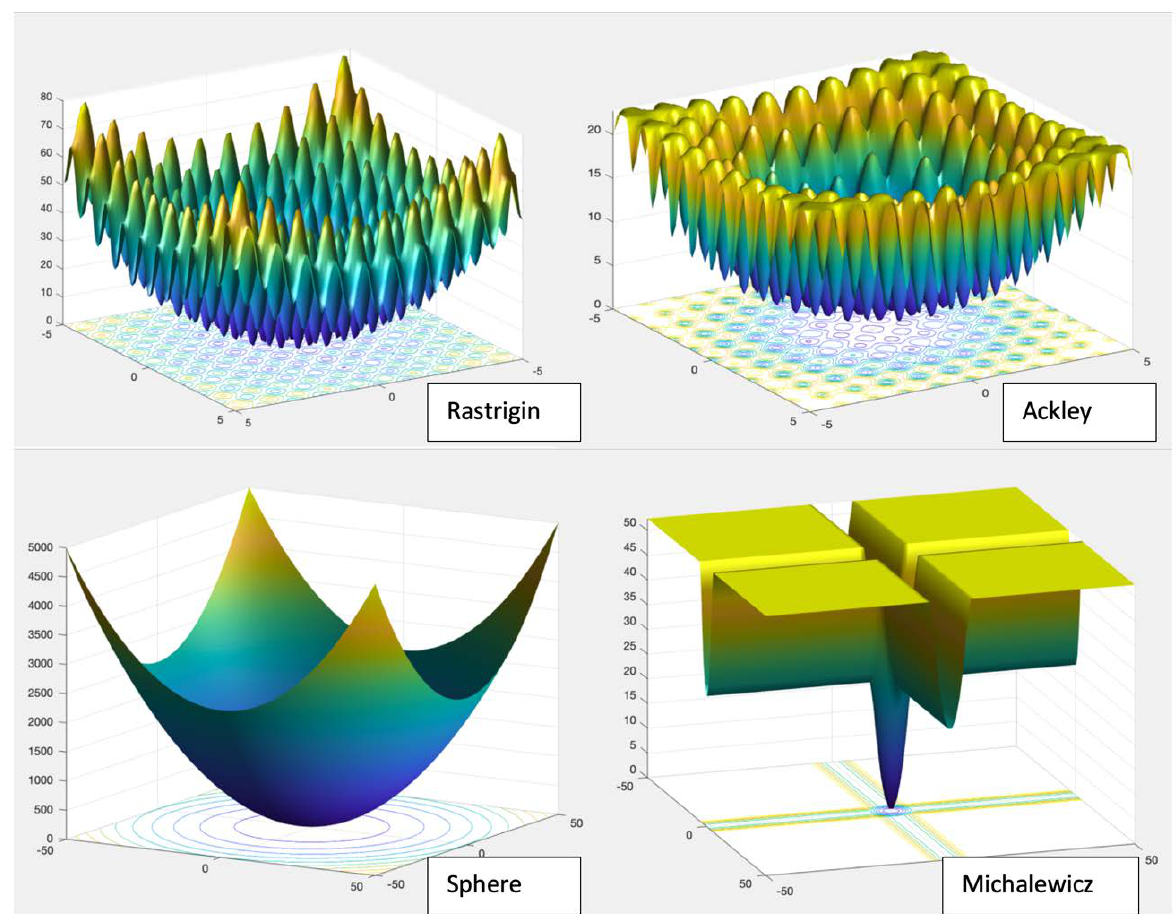
Figure 5. Example of benchmark mathematical functions.